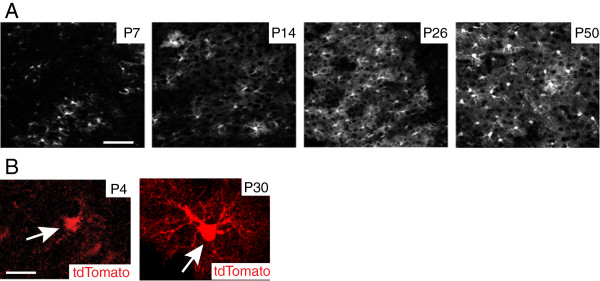
Morphological maturation of astrocytes during postnatal development. (A) Growth of cortical astrocyte processes illustrated with tdTomato reporter on EAAT2 tdTomato transgenic mice during postnatal development; Scale bar: 100 μm; (B) A magnified view of typical astrocyte morphology at P4 and P30 from cortex of EAAT2 tdTomato mice. Scale bar: 50 μm.